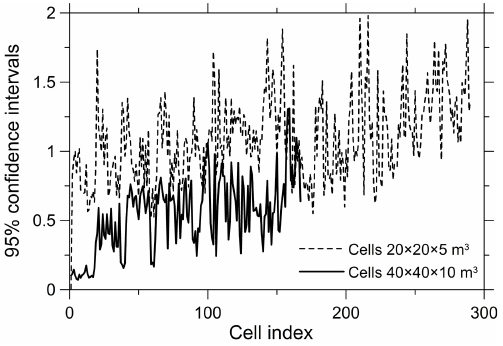
Fig. 4. The 95% confidence intervals computed considering the discretization of the matrix A : (a) cells of 40m × 40m × 10m; (b) cells of 20m × 20m × 5m.